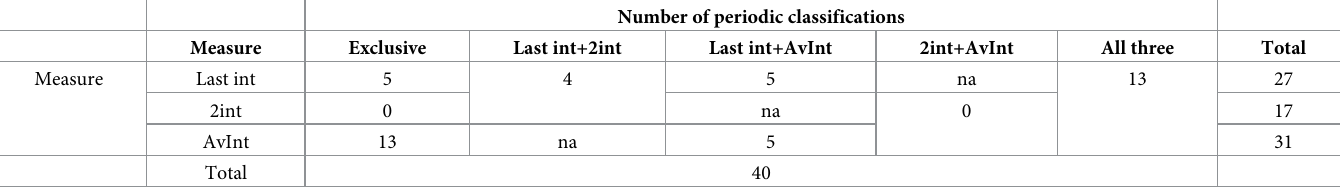
Each row represents a given measure. Column 3 (Exclusive): number of Q+A pairs classed as Periodic by the criterion listed in the row label ‘Measure’. Last int+2int: number of pairs classed as Periodic by both last interval and 2interval measures but not the AverageInterval measure. Similarly, for the other columns (‘All three’ means last interval, 2interval and AverageInterval